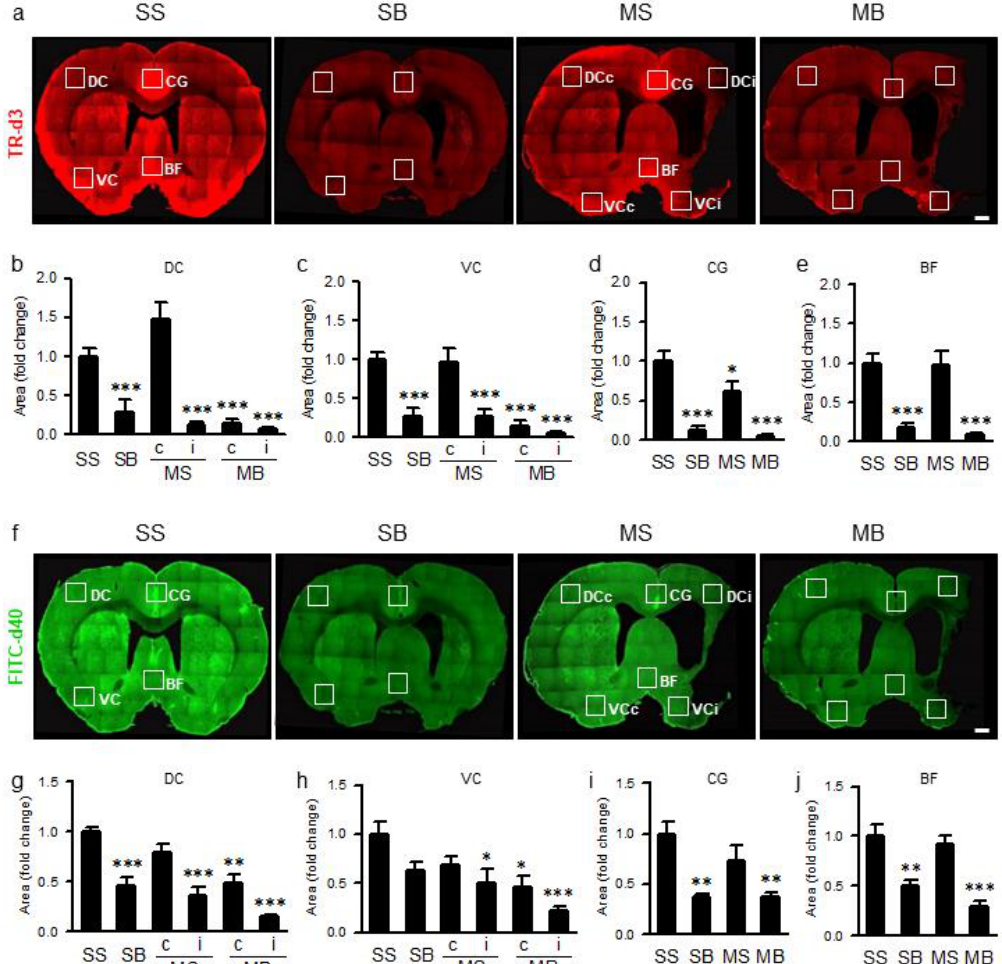
Figure 6. ( a ) Parenchymal infiltration of cerebrospinal fluid tracer (CSF) with Texas Red ® -conjugated dextran of 3kDa (TR-d3) and its quantification in dorsal cortex (DC, b ), ventral cortex (VC, c ), cingulate gyrus (CG, d ), and basal forebrain (BF, e ). ( f ) Parenchymal infiltration of CSF tracer with fluorescein isothiocyanate (FITC)-conjugated dextran of 40kDa (FITC-d40) and its quantification in DC ( g ), VC ( h ), CG ( i ), and BF ( j ). n = 6 per group; scale bar = 1 mm; SS, sham + sham; SB, sham + BCCAo; MS, MCAO + sham; MB, MCAO + BCCAo; MCAO, middle cerebral artery occlusion; BCCAo, bilateral common carotid artery occlusion; c, contralateral; i, ipsilateral; * p < 0.05, ** p < 0.01, and *** p < 0.001 compared to SS.